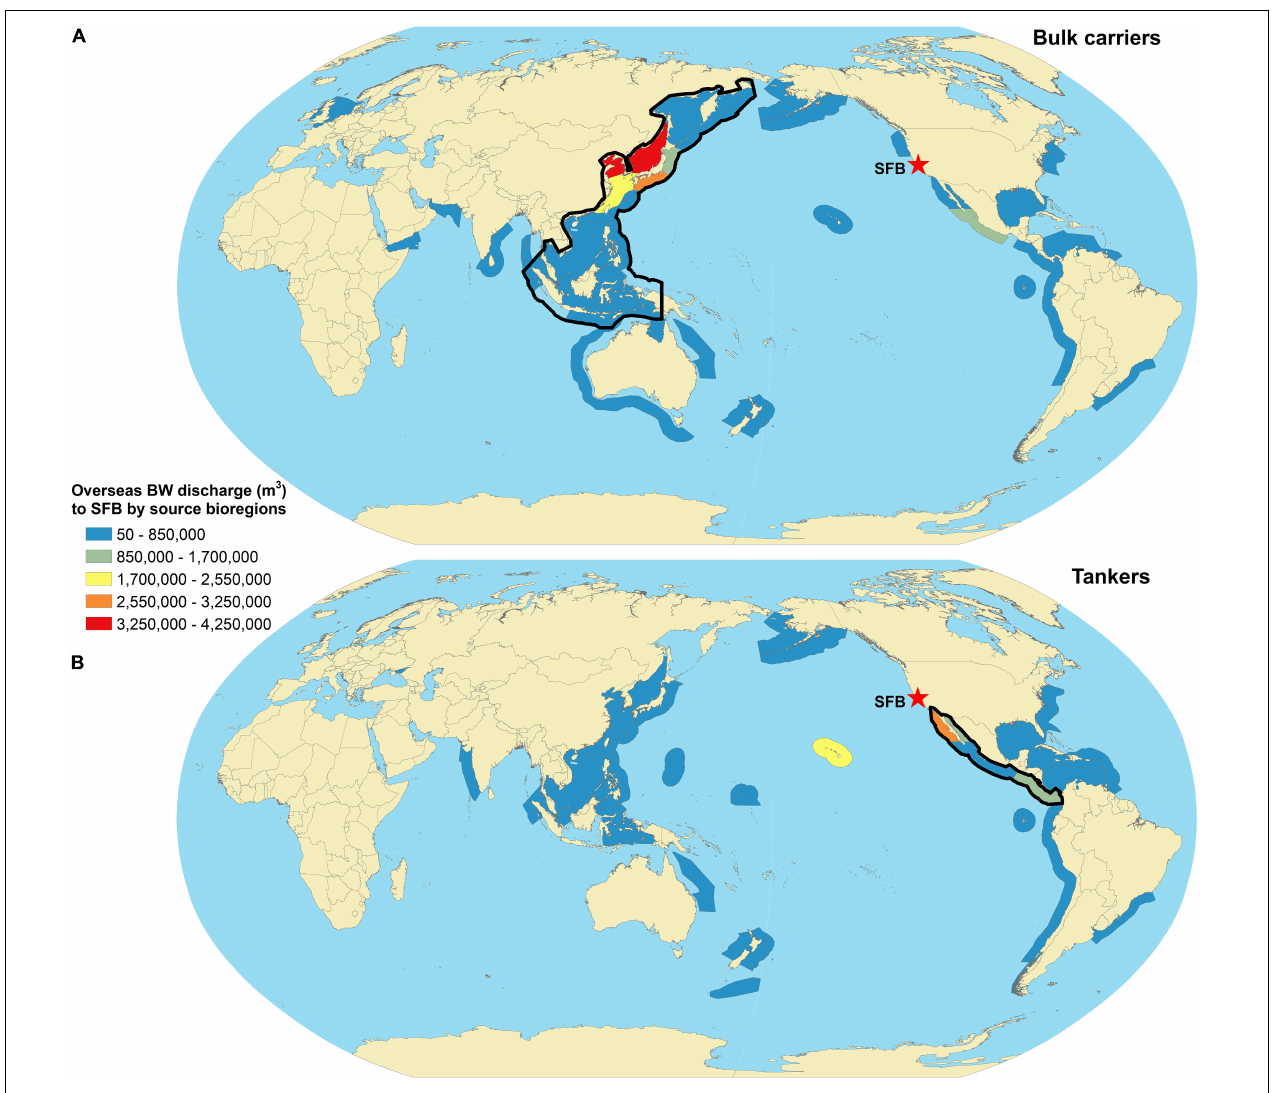
Central America (upper and lower, respectively) and shown in Table 1